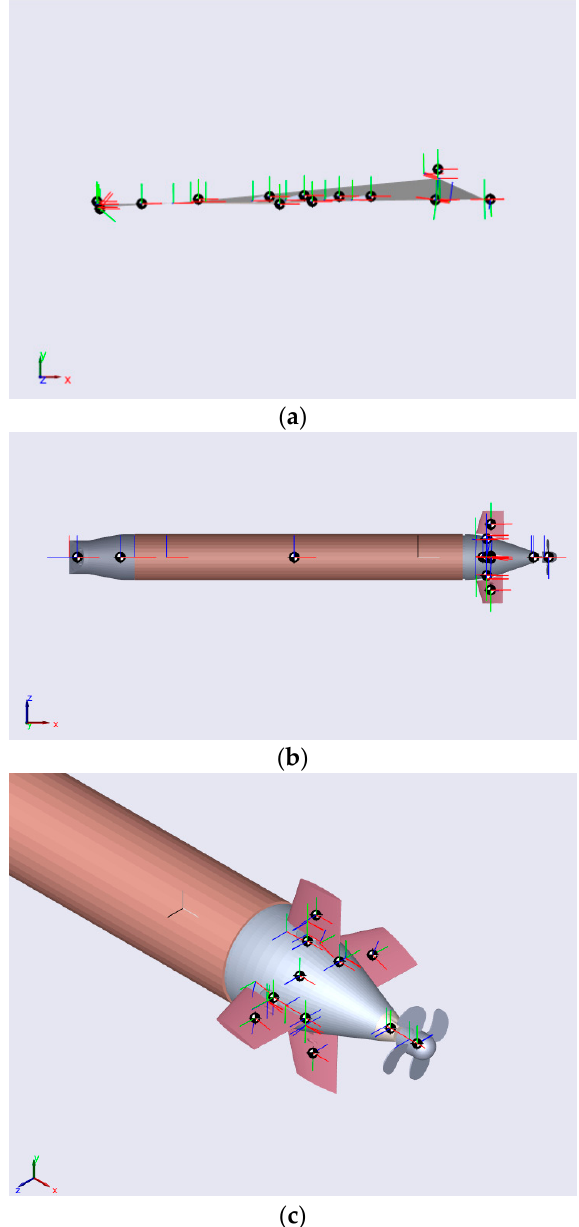
Figure 7. Diagrams of ( a ) incomplete modeling generated by excessive components; ( b ) simplified model and coordinate system; and ( c ) enlargement of post-driver system.